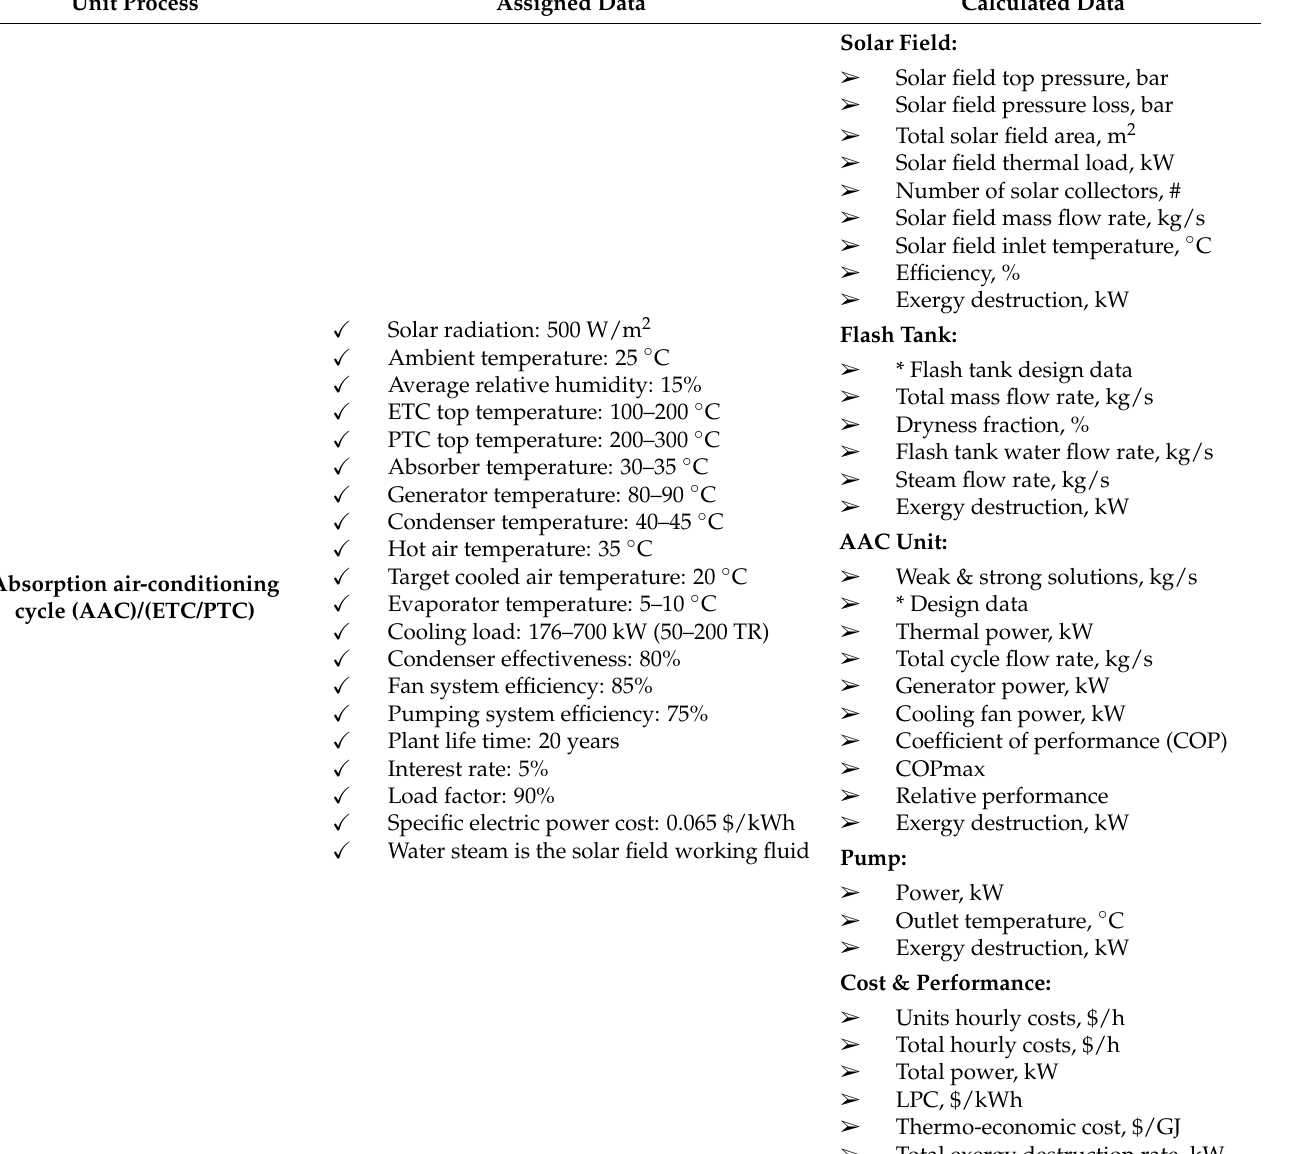
Table 1. Design data for the solar absorption system configurations